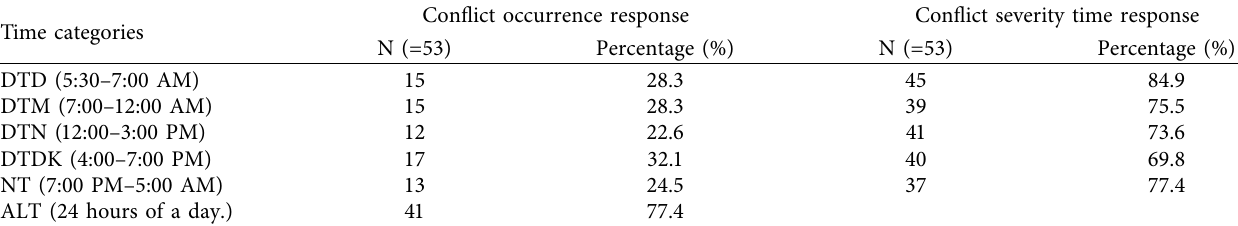
Table 2: Time of conflict occurrence and severity between humans and wild animals.